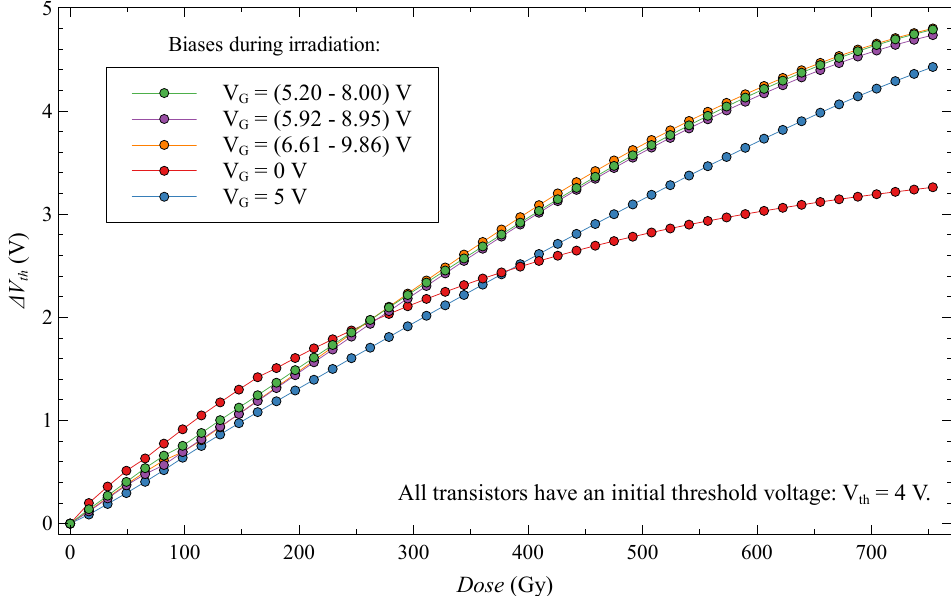
Figure 21. Threshold voltage shift for second subgroup of EPADs with dynamic 12 V bias during irradiation.